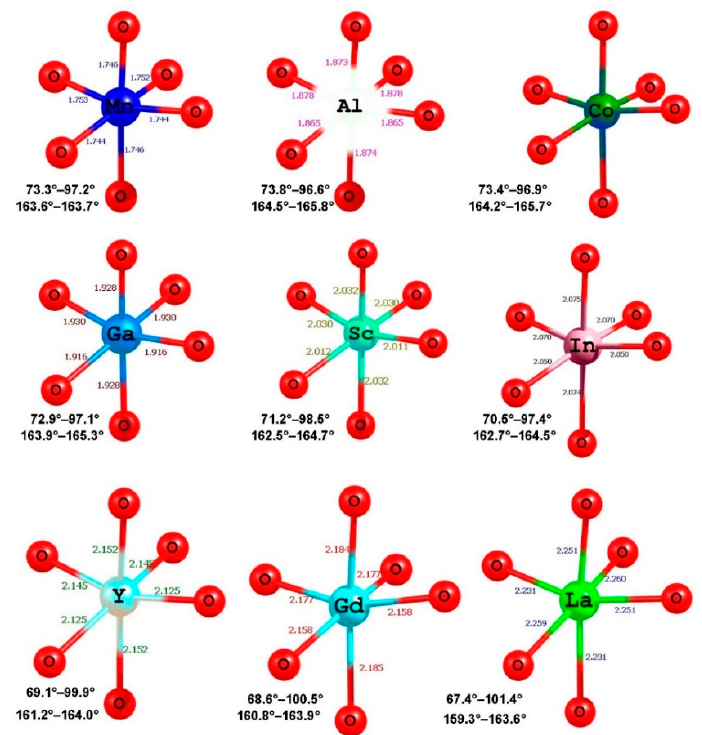
Figure 6. Distorted octahedral MnO 6 units in the relaxed structure of undoped Li 2 MnO 3.